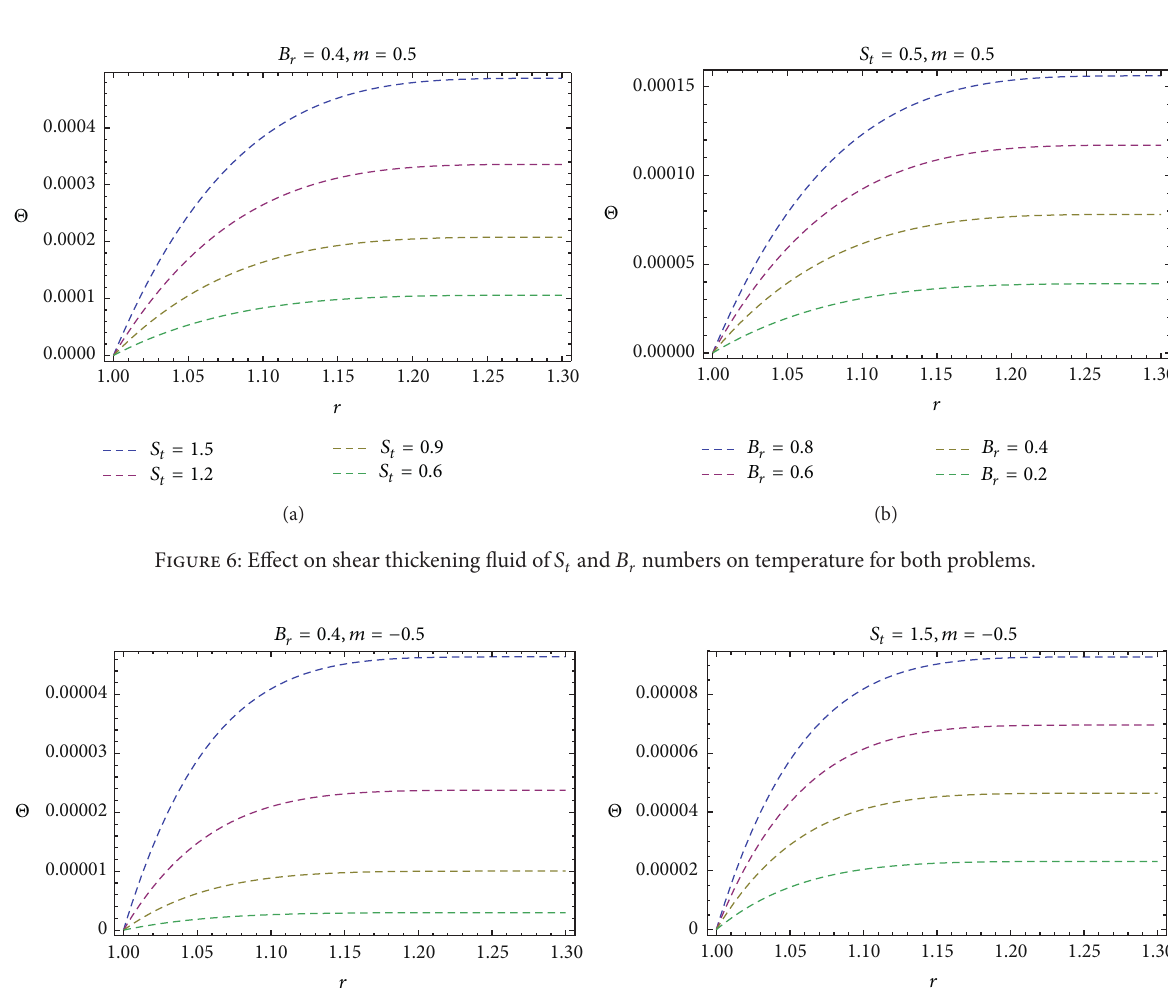
Figure 5: Effect of 𝑚 on temperature for both problems.